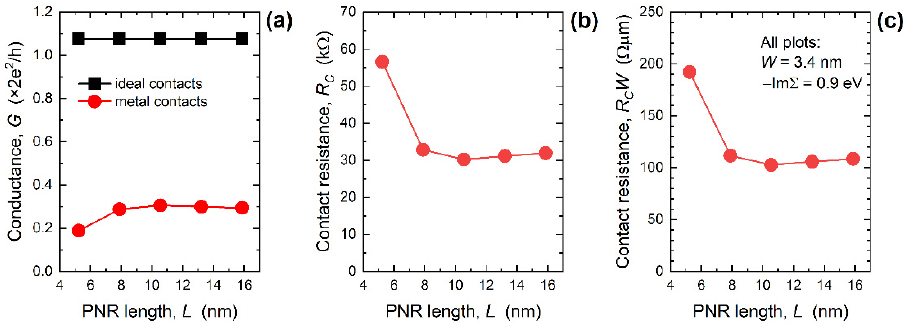
Figure 5. Length-dependence of ( a ) conductance, ( b ) contact resistance, and ( c ) width-normalized contact resistance in 3.4 nm-wide PNRs. For all MEC-PNRs, − Im Σ R = 0.9 eV.